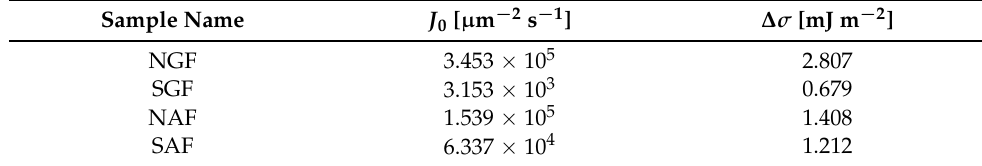
Figure 5. ( a ) Example of POM images showing the isothermally crystallizing microstructure at 130 ◦ C around a neat glass fiber (NGF) in the top panel and a neat aramid fiber (NAF) in the bottom panel. ( b ) Quantification of the quiescent heterogeneous nucleation rate as a function of temperature for the four different fibers considered here. The lines are model fits that yield the rate parameters given in Table 1. Table 1. Nucleation density